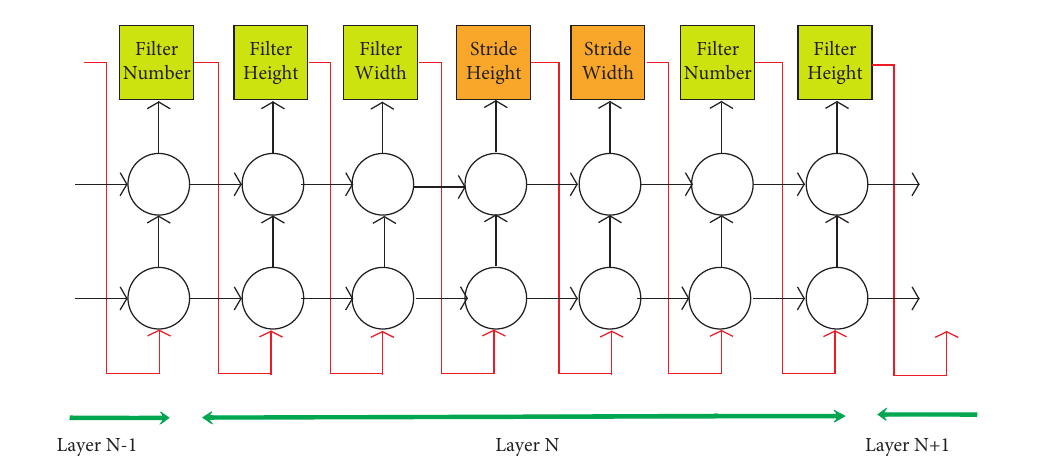
Figure 1: NAS method controller.